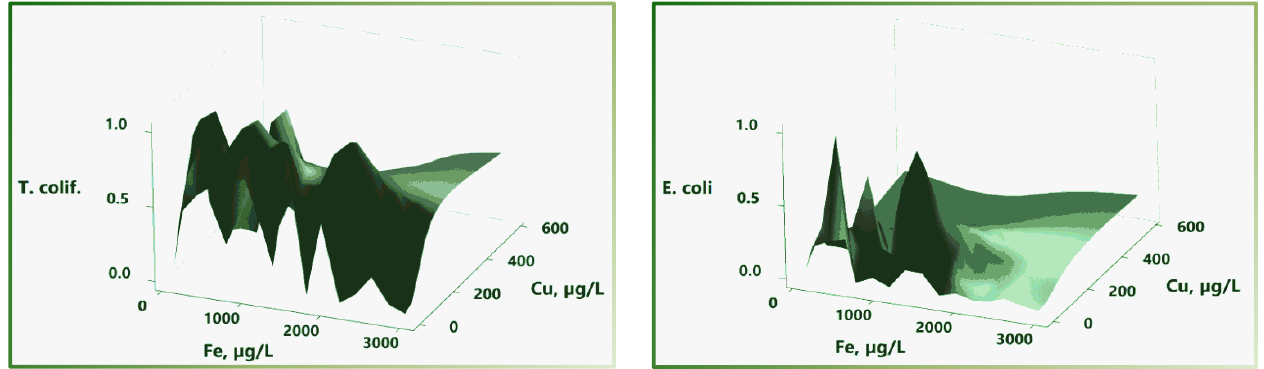
Figure 14. 3D surface plot of the combined interactions of Cu and Fe concentrations on TC ( left ) and E. coli ( right ).